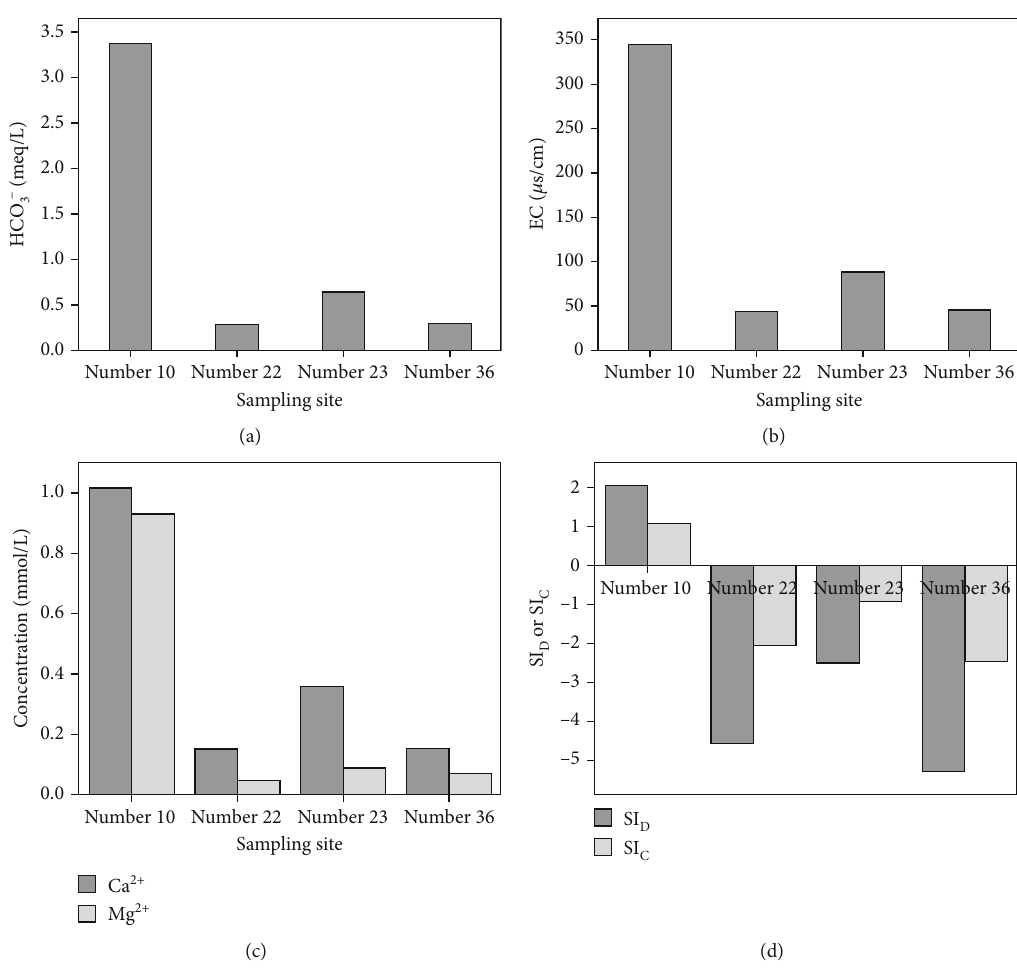
Figure 9: Water chemistry of No. 10 water and No. 22, 23, and 24